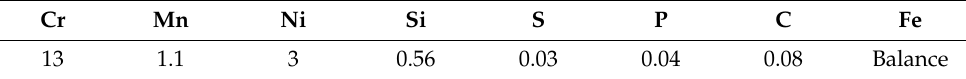
Table 2. Chemical composition of the 410 SS used in this work